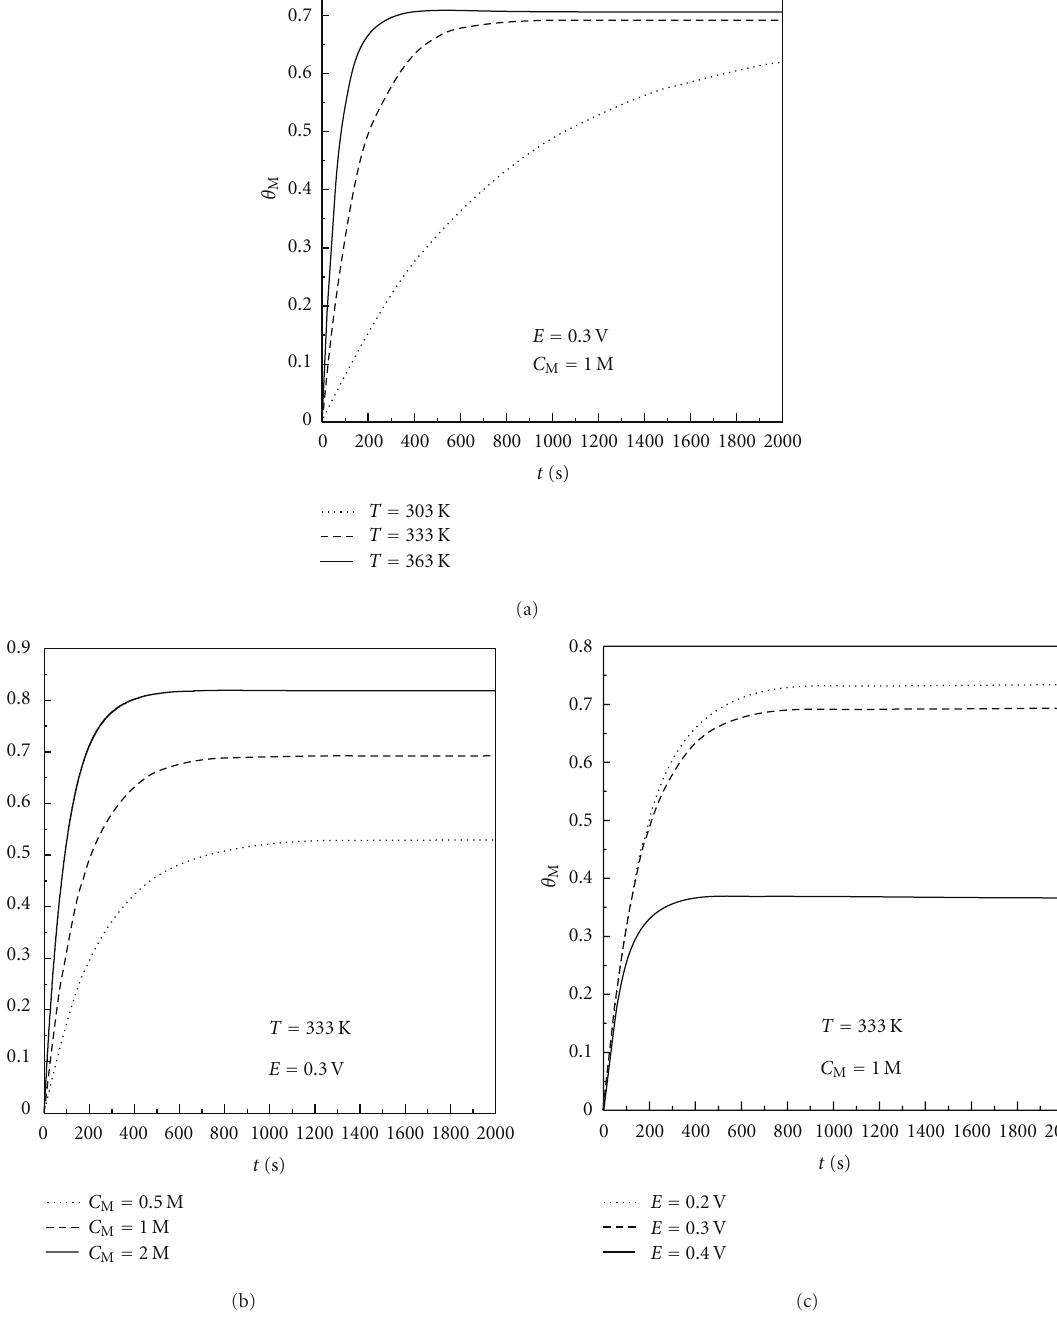
Figure 3: Transient of the coverage of methanol with di ff erent operating (a) temperature, (b) methanol concentration, and (c)